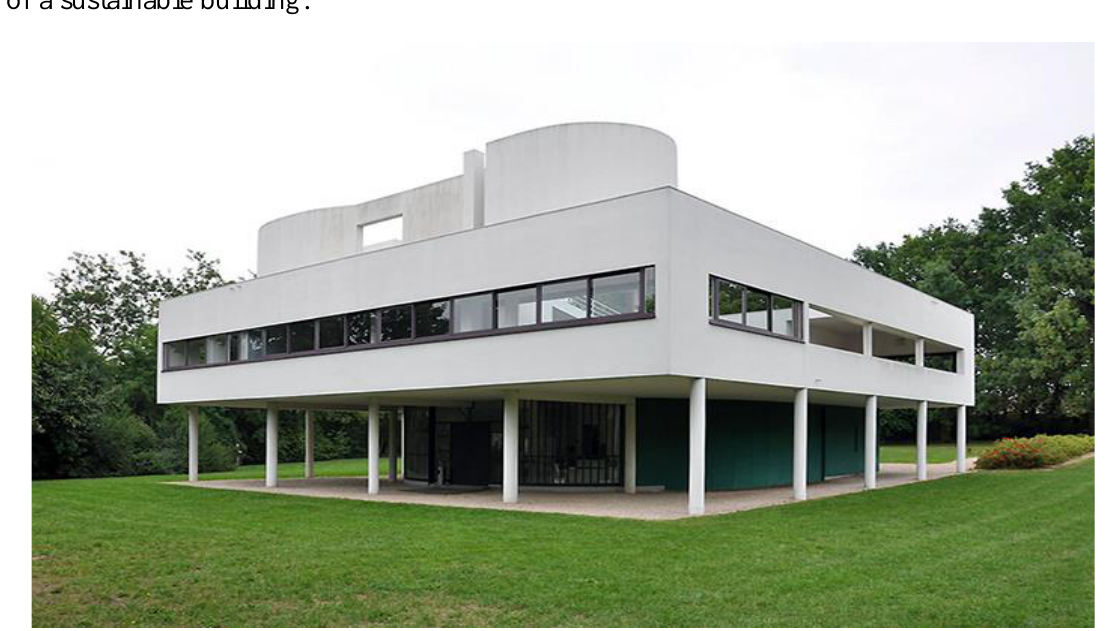
Figure 6. Exterior view of Villa Savoye, Poissy, France. [Source: Renato,